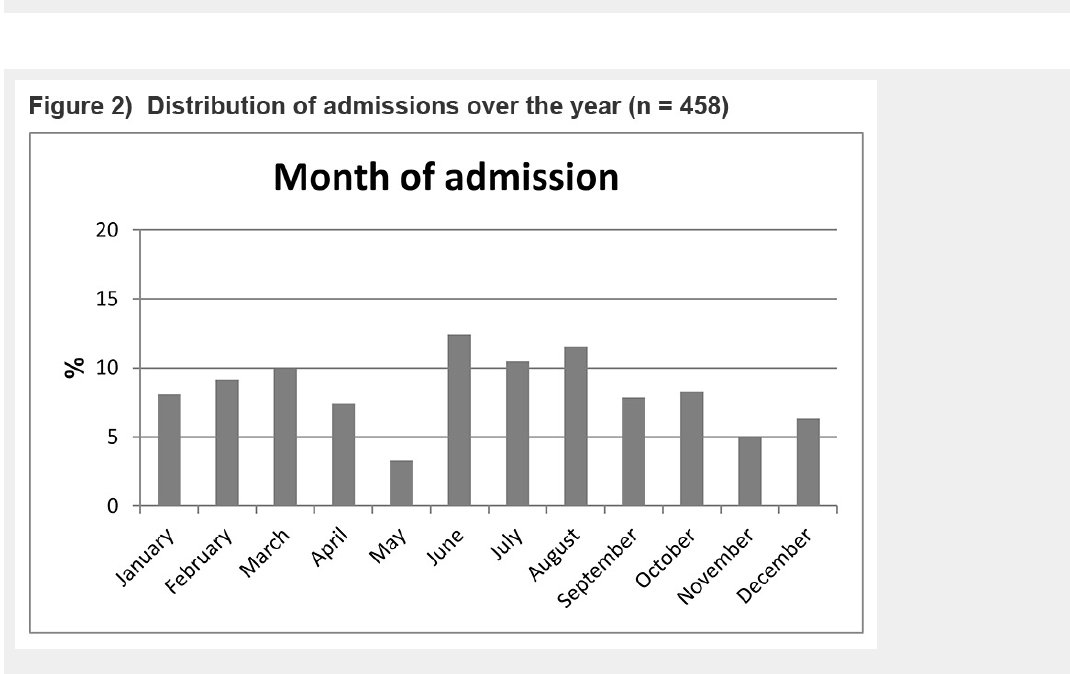
Figure 1 Distribution of Injury Severity Scores (n = 458).